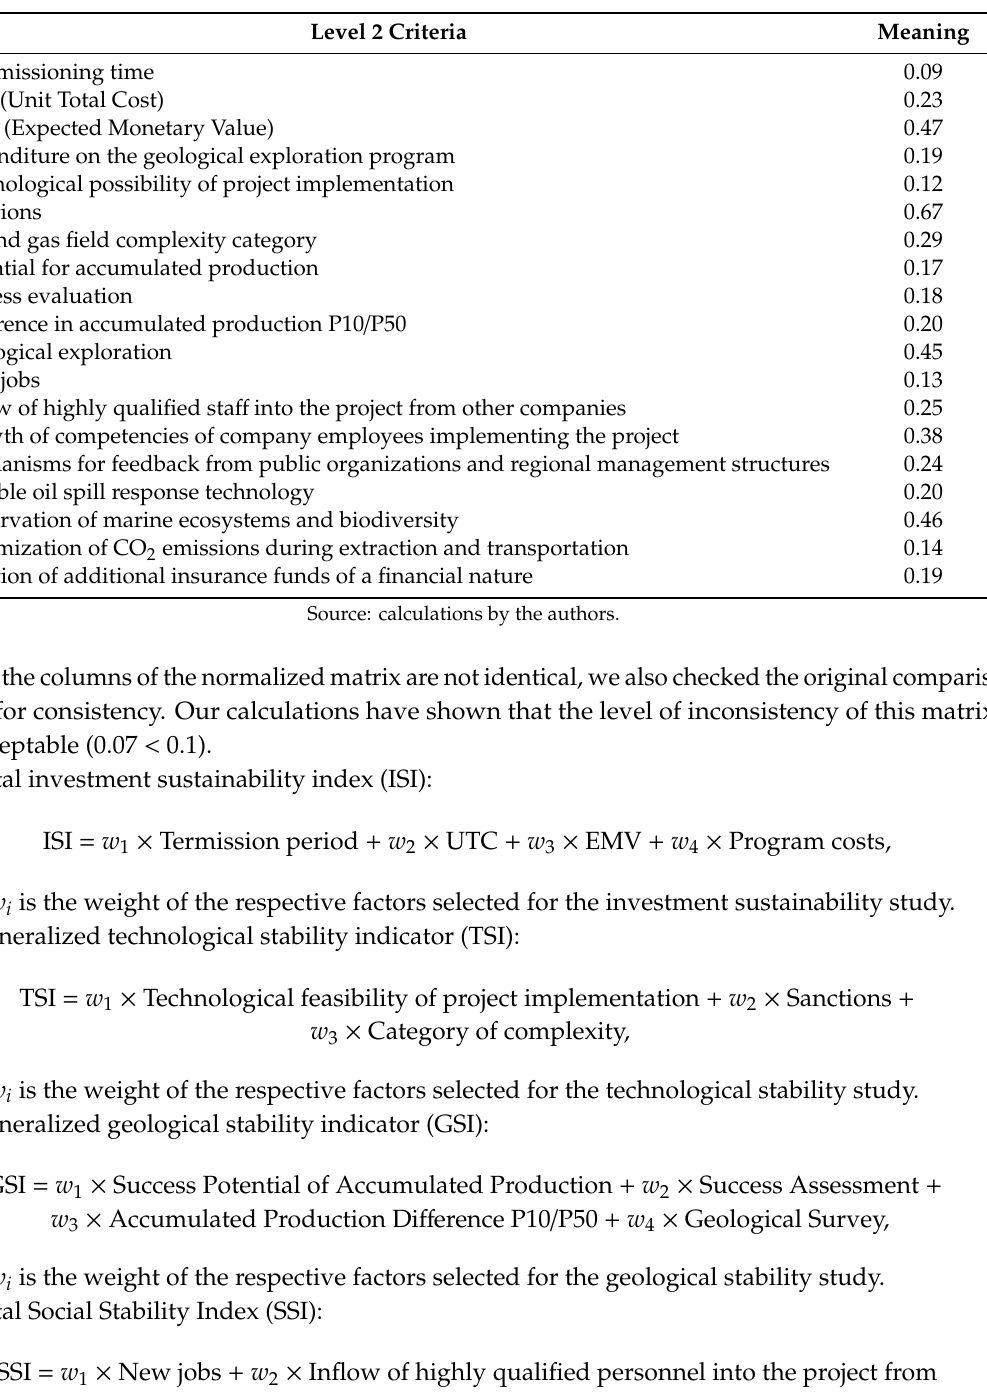
Table 6. Calculation of the second level criteria priority